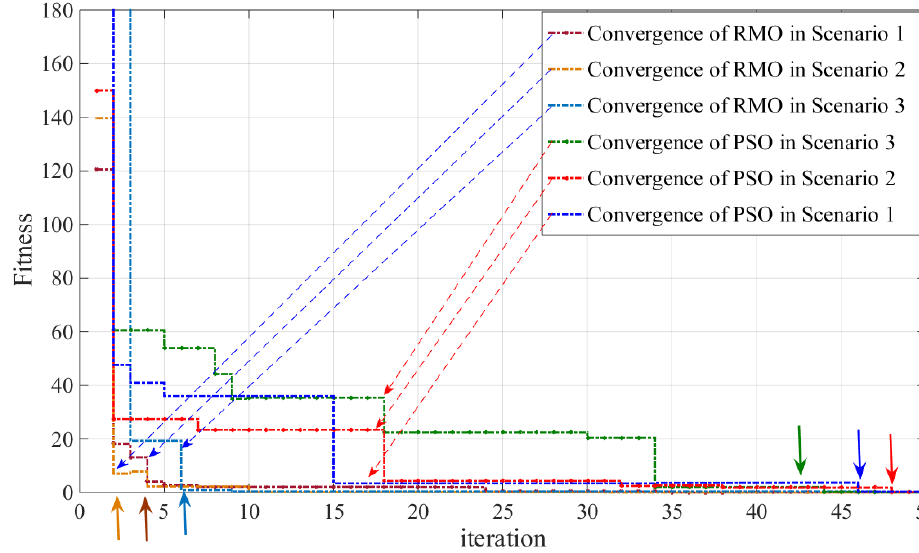
Figure 13. Convergence of the proposed RMO method versus PSO technique for three shading conditions.